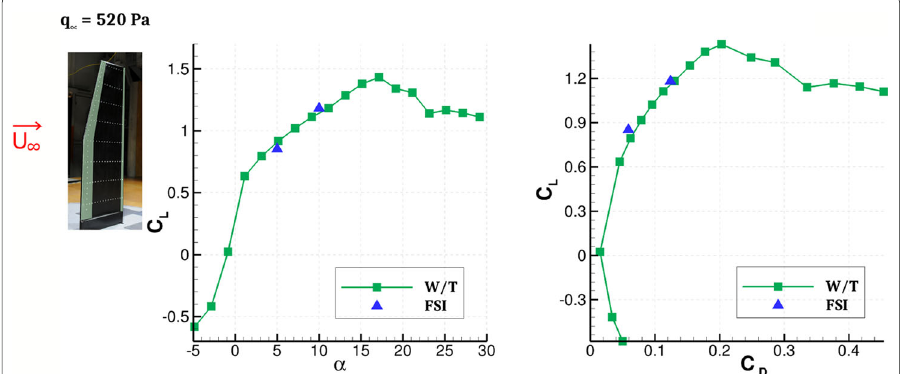
Fig. 8 Comparison of C L - α and C L - C D for FSI and wind tunnel data at q ∞ = 520